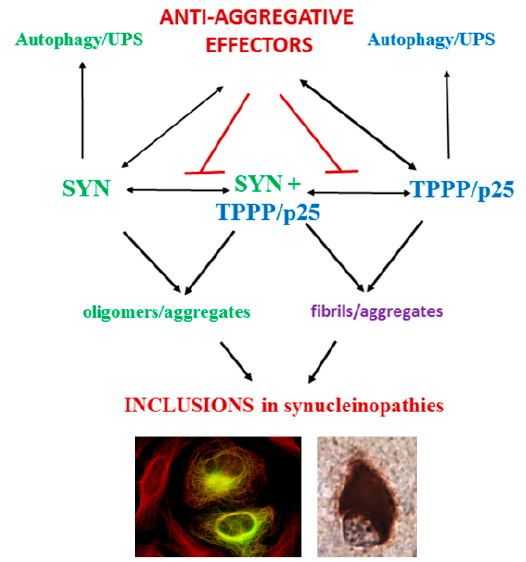
Figure 1. Scheme of the established interactions of SYN and TPPP/p25 leading to inclusion for- mation in human living cells and brain tissues of patients. UPS: ubiquitin proteasome system. Con- struction based upon own publications [34–36].